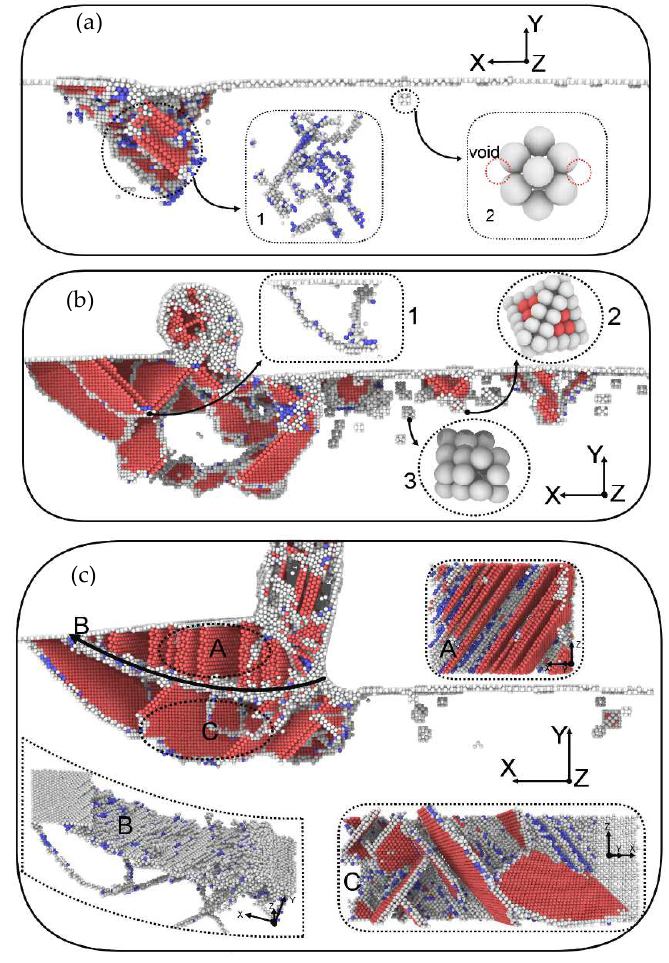
Figure 6. Internal defects of the workpiece at different chip states. ( a ) Plowing, ( b ) spherical chip, and ( c ) strip chip . Red represents HCP atoms, white represents surface and amorphous atoms, and blue represents BCC atoms.